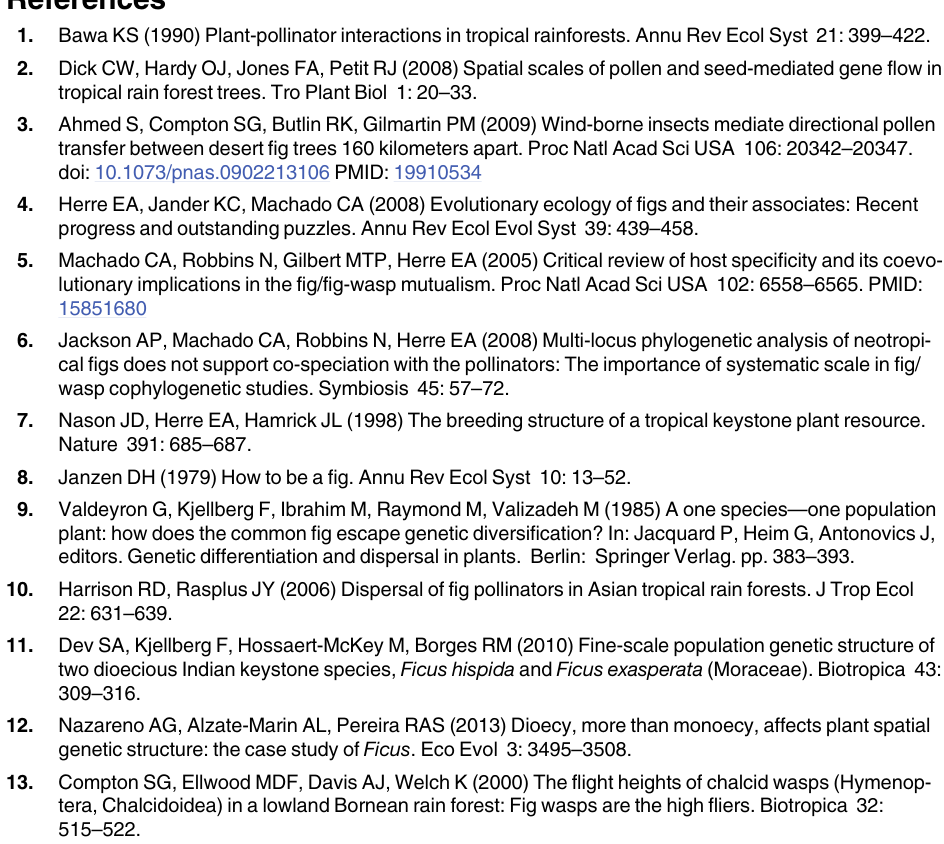
S1 Table. Sampling sites of F . inspida in Panama, Costa Rica and Peru with the number of samples per plot (n) and the spatial coordinates of the locality . S2 Table. Characterization of the microsatellite markers for Ficus samples collected in the Barro Colorado Nature Monument. For each marker, we provide the percentage of missing ), the expected heterozygosity (H ) and the inbreeding coeffi- data, the number of alleles (N a e cient (F IS